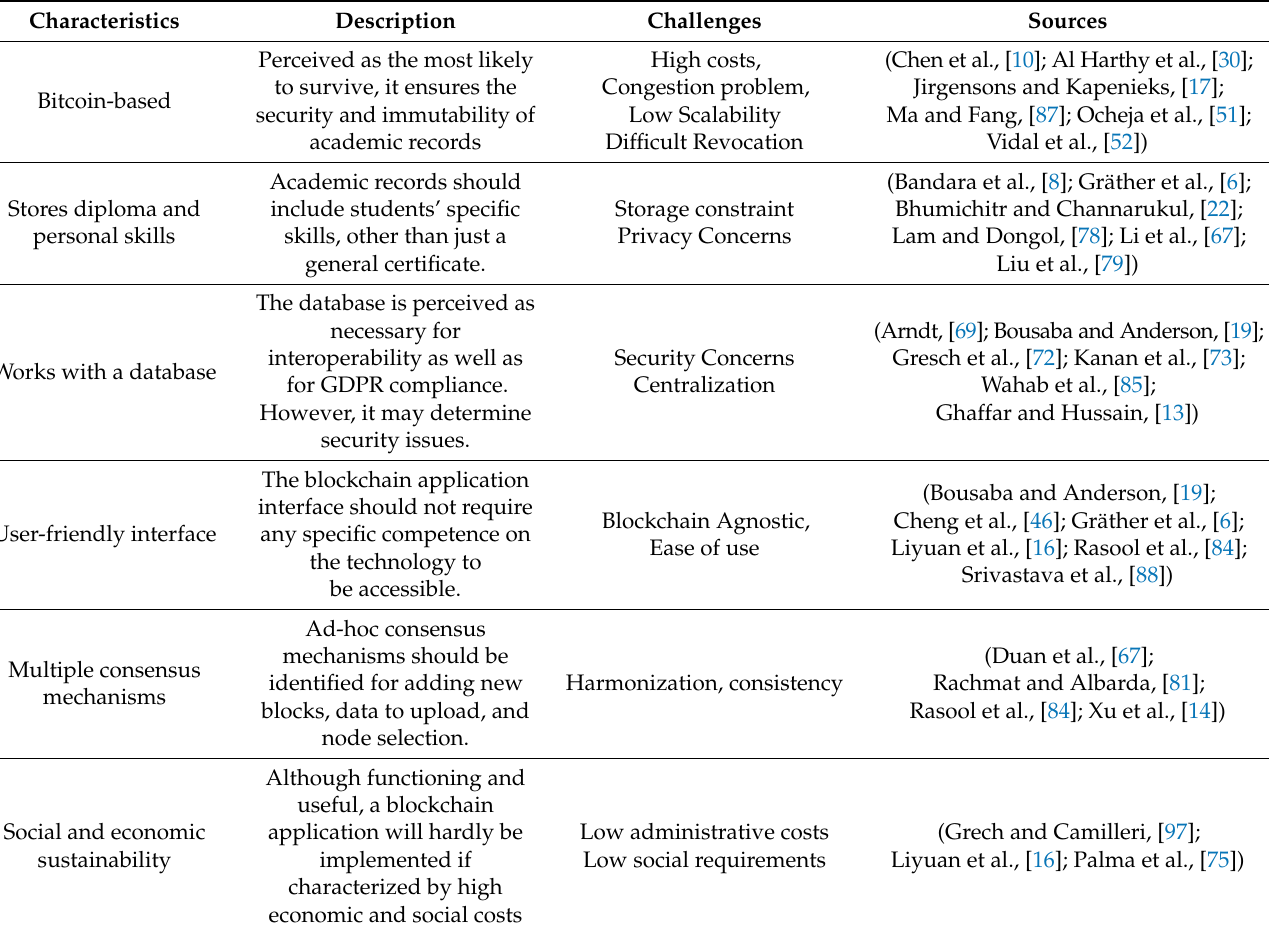
Table 4. Desired characteristics of an academic blockchain